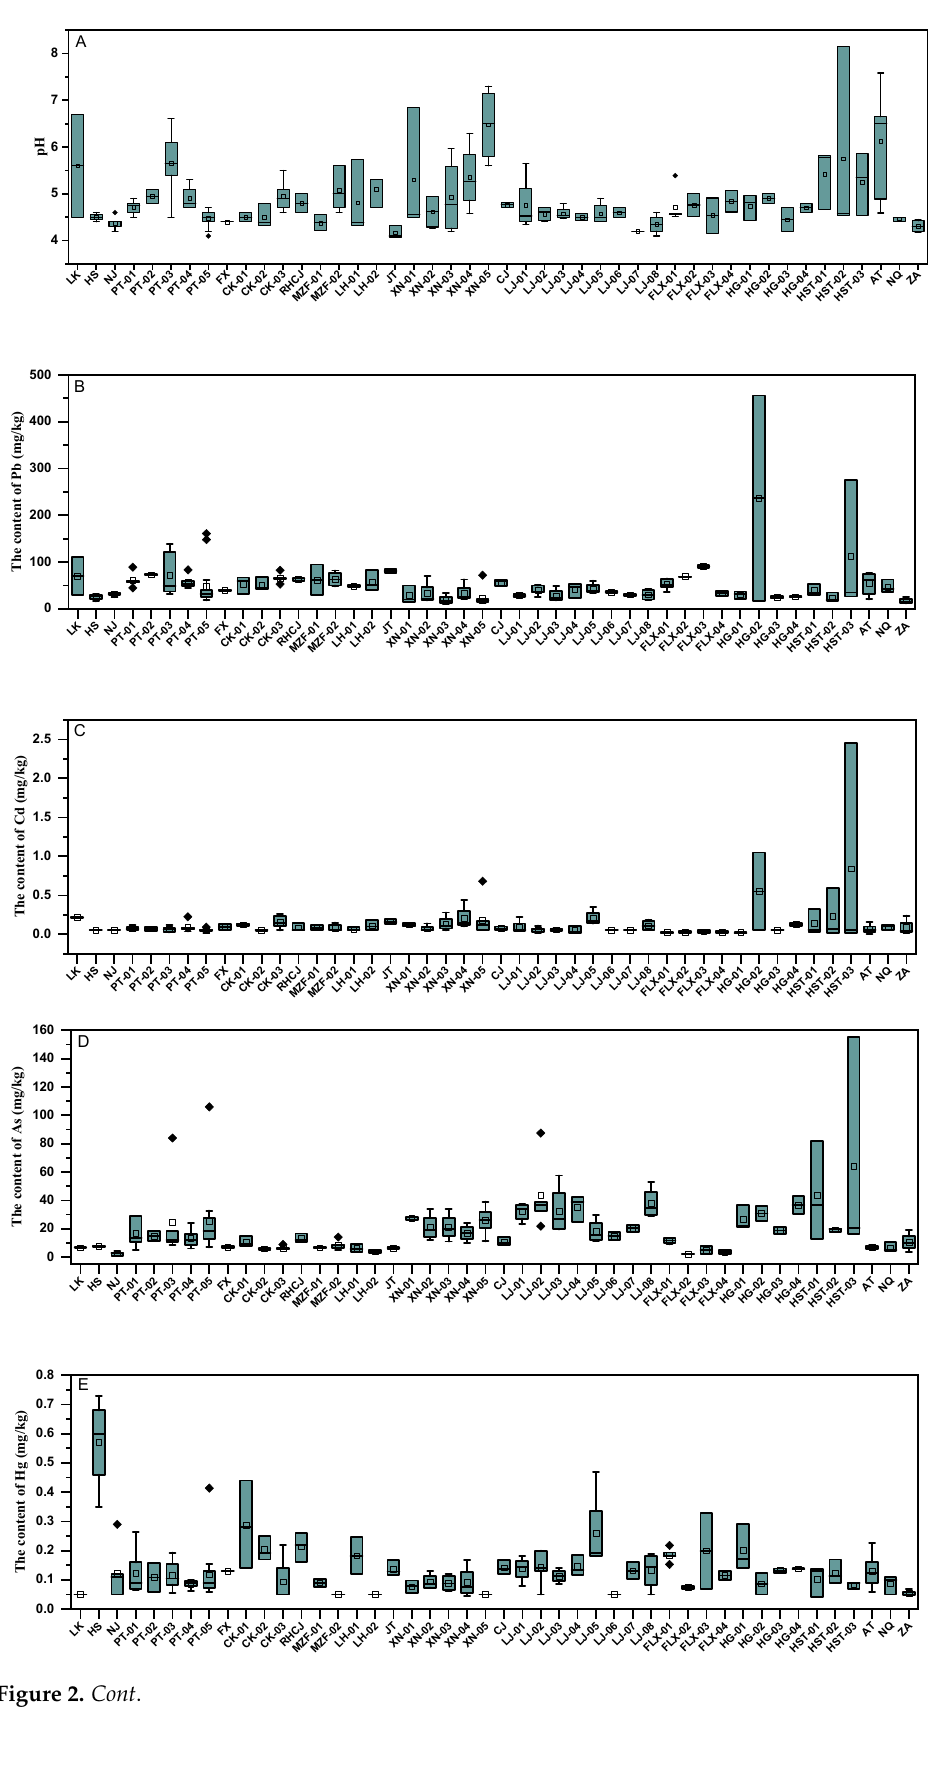
Figure 2. pH value ( A ) and heavy metal content of Pb ( B ), Cd ( C ), As ( D ), Hg ( E ), and Cr ( F ) from different bamboo shoot areas. The coefficient of variation (CV) usually reflects the difference in the distribution of heavy metal content in each sample. The value of the coefficient of variation is related to human activities. The coefficient of variation CV ≤ 10% indicates weak variability; 10% < CV < 100% means moderate variability; CV ≥ 100 % refers to strong variability [45]. The calculation results of CVs are shown in Table 2. The CV value analysis results show that, compared with other heavy metals, 72% of the pH is lower than 10% in different regions, which belongs to the weak variation category. As for the CV values of Hg and Cr, 80.43% and 82.61% of the sample regions were moderate variability, respectively, and other re- gions were weak variability. However, the CV value analysis results of Pb, Cd, and As showed that in the PT-03 (As), HG-02 (Pb, Cd), HST-01 (Cd), HST-02 (Cd), HST-03 (Pb, Cd and As), and ZA (Cd) areas, the CV values of the corresponding heavy metals ex- ceeded 100%. The high CVs of Pb, Cd, and As indicated that these metals in the study soil differed greatly with respect to different sample areas and were seriously impacted by human activities.